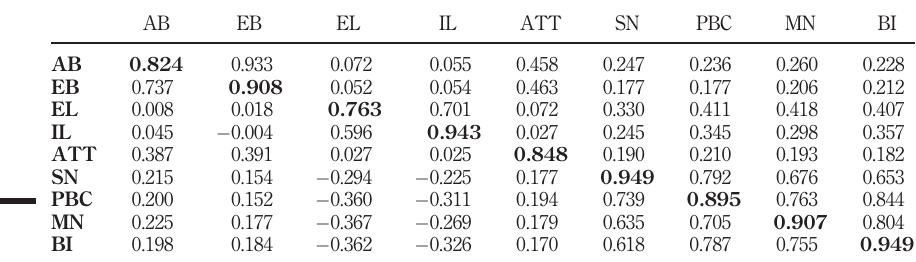
Table 2. Discriminant